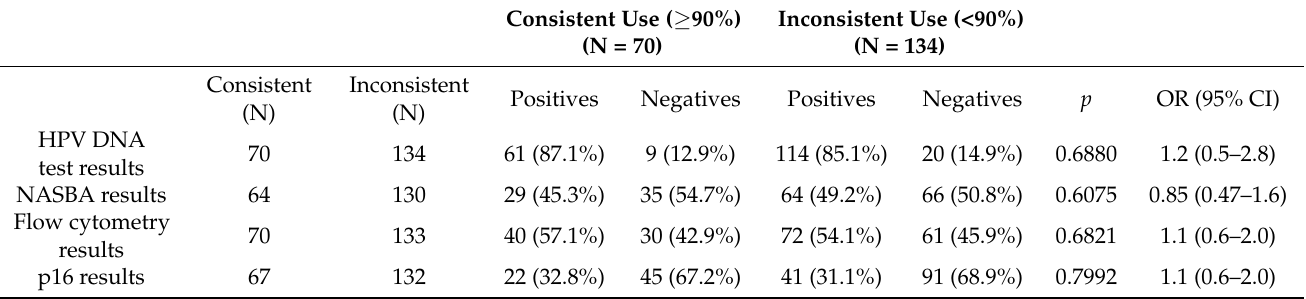
Table 3. Laboratory outcomes for the two groups and statistical comparison during the study entry.